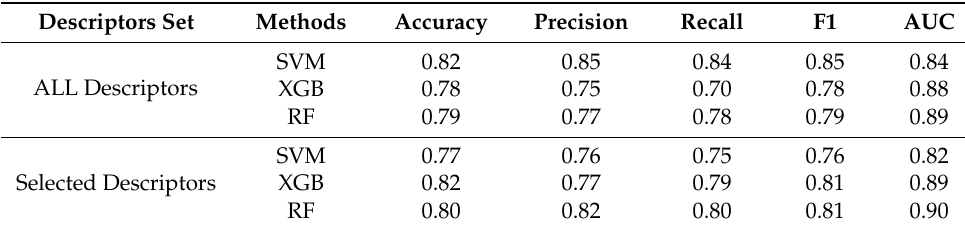
Table 2. Evaluation metrics for binary models.